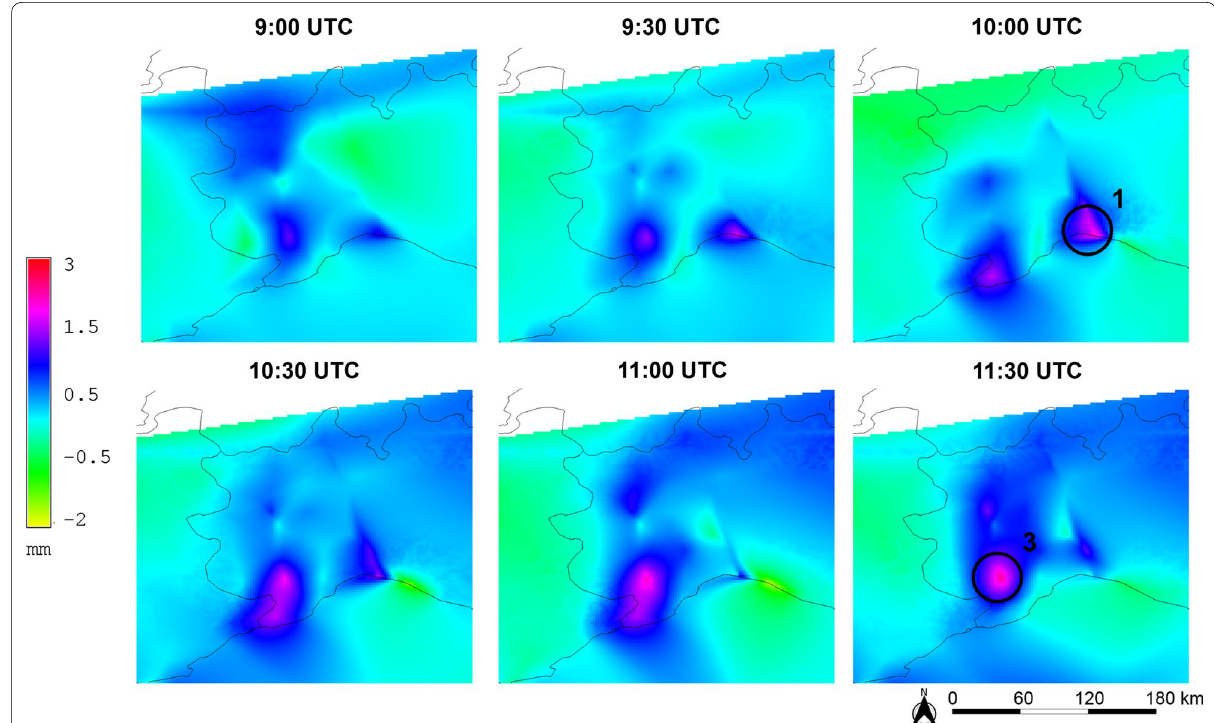
Fig. 16 30-minute extraction from the 6-minute ∆PWV maps for the severe event on November 4, 2011, differentiated with respect to November 4, 2011, 08:30 UTC